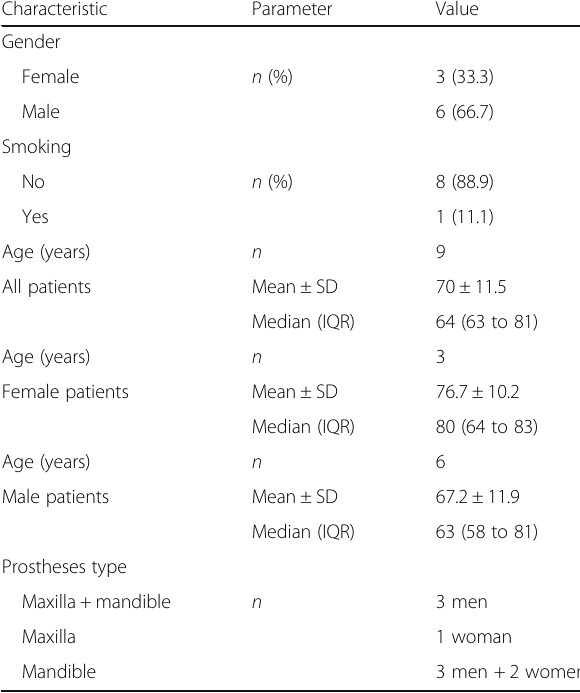
Table 1 Patients ’ characteristics ( n = 9)